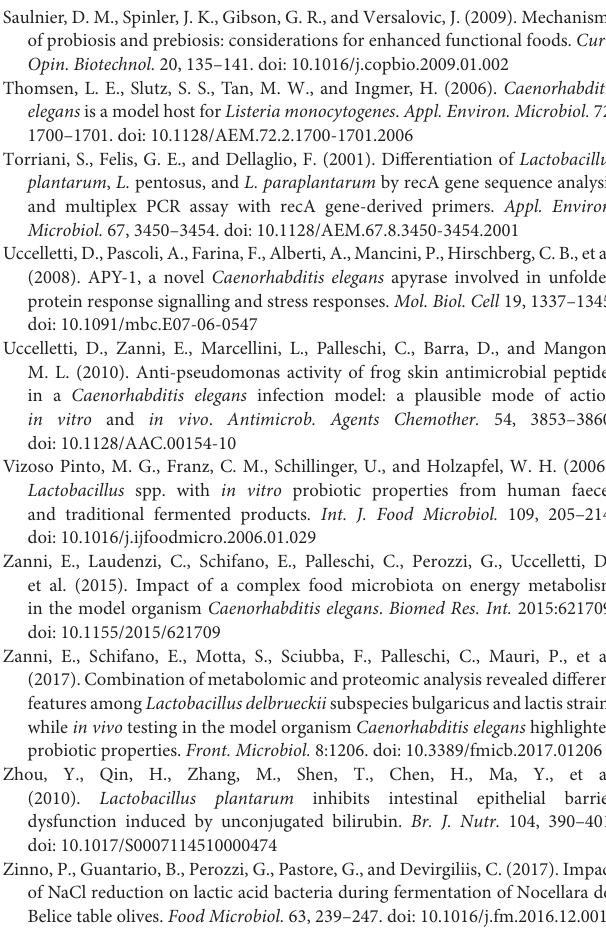
Belice table olives. Food Microbiol. 63, 239–247. doi: